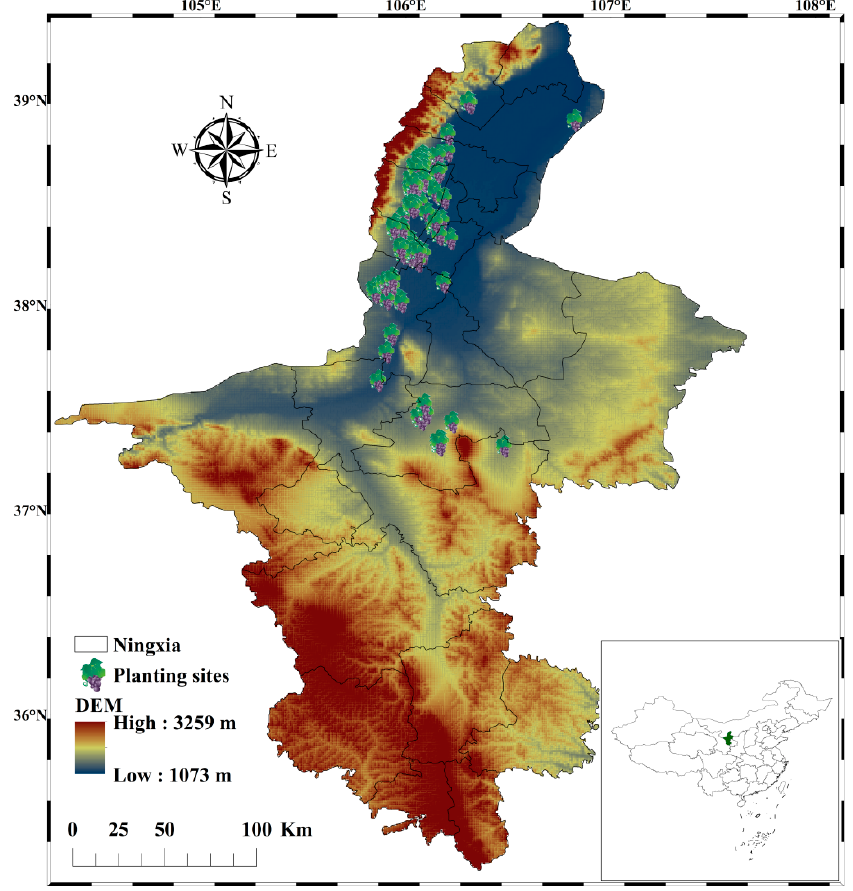
Figure 1. Study region and actual vineyard distribution in Ningxia (DEM = altitude).